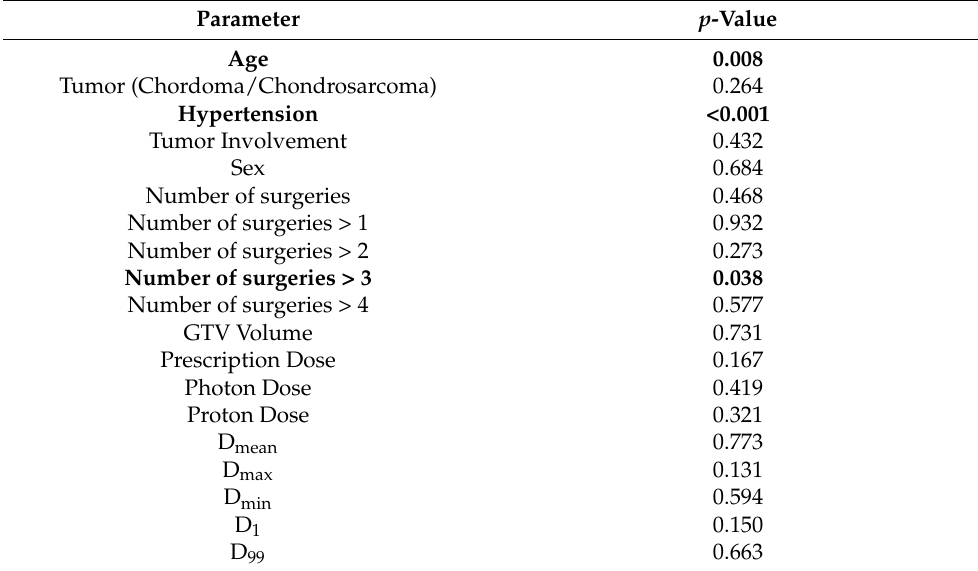
Table 2. Univariable correlation between RION incidence and a range of variables. Statistically significant variables are highlighted in